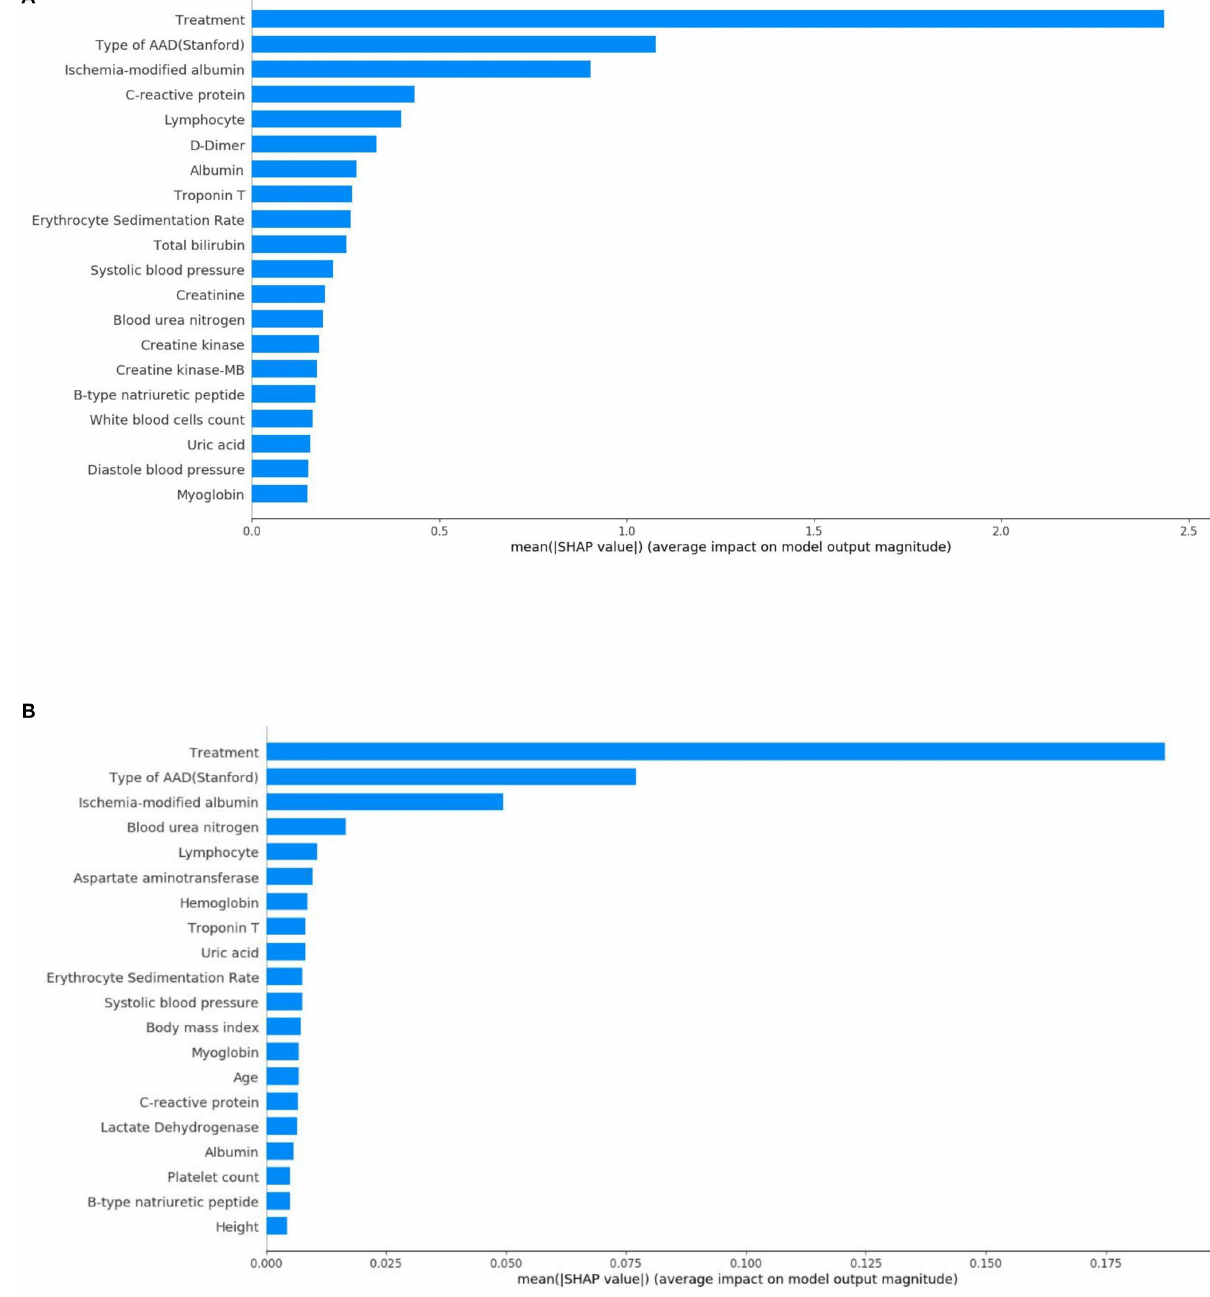
FIGURE 5 | Standard bar charts of the average absolute SHAP values of each feature in the XGBoost model (A) and DT model (B) .